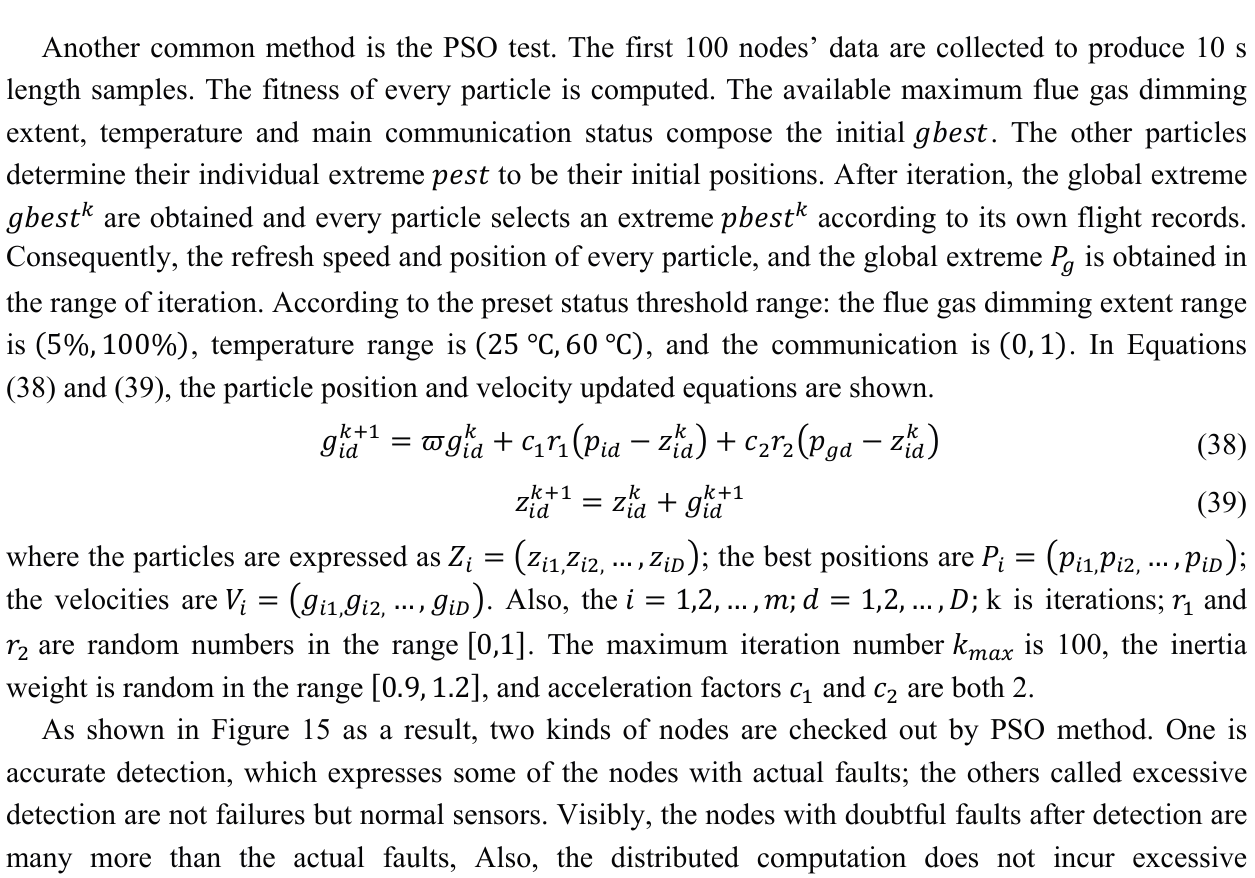
Figure 14. The accuracy rate of diagnosis of the rate of change of data